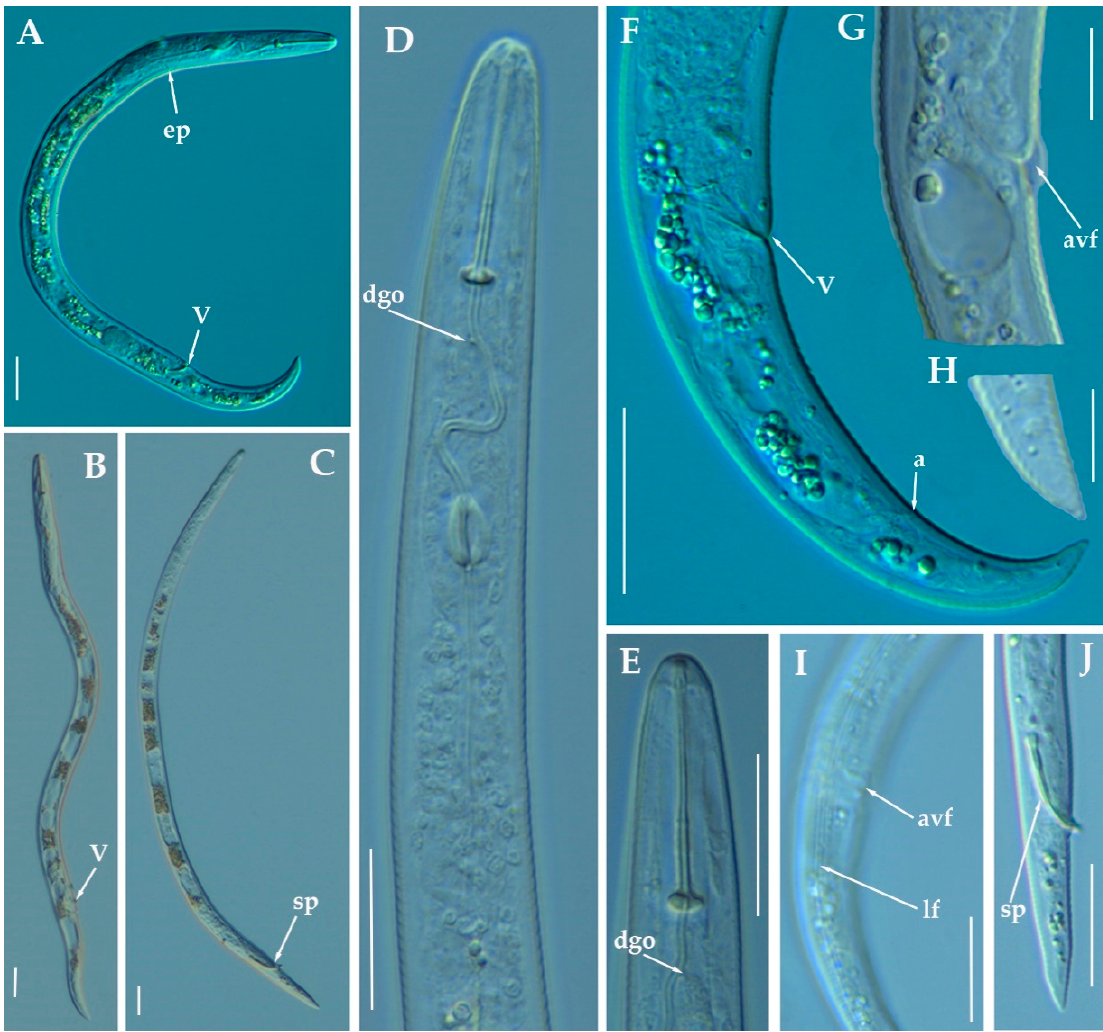
Figure 16. Light photomicrographs of Paratylenchus holdemani Raski, 1975. ( A , B ): Entire female with vulva arrowed; ( C ): Entire male with spicules arrowed; ( D ): Female pharyngeal region; E: Female lip region; F: Female posterior region with vulva and anus (arrowed); ( G ): Detail of vulva showing advulval flap (arrowed); ( H ): Detail of female tail tip; ( I ): Female posterior region showing lateral field and advulval flap (arrowed); ( J ): Male tail with spicules arrowed. Scale bars ( A – F , I , J = 20 μ m; G – H = 10 μ m). (Abbreviations: a= anus; avf= advulval flap; dgo= pharyngeal dorsal gland orifice; ep = excretory pore; lf = lateral field; sp = spicules; V = vulva).